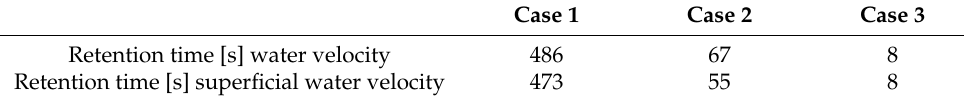
Table 4. Hydraulic retention times.